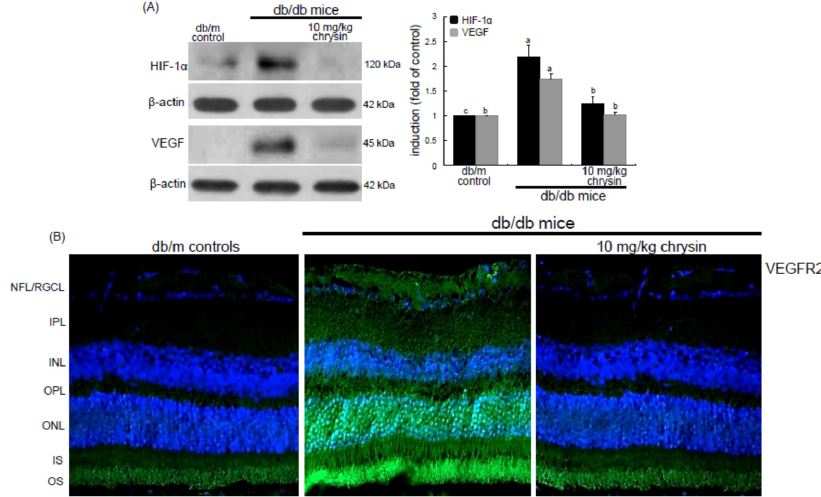
Figure 3. Inhibition of retinal tissue induction of HIF ‐ 1 α , VEGF and VEGFR2 by chrysin. The db/db mice were orally supplemented with 10 mg/kg chrysin daily for 10 weeks. The db/m mice were introduced as control animals. Mouse retinal tissue extracts were subject to Western blot analysis with a primary antibody against HIF ‐ 1 α and VEGF ( A ). β‐ Actin protein was used as an internal control. Bar graphs (mean ± SEM, n = 3) in the right panel represent densitometric results of left blot bands. Values not sharing a common letter differ, p < 0.05. Histological sections of mouse retina were immunohistochemically stained using a primary antibody of VEGFR2 ( B ). The VEGFR2 was identified as FITC-green staining and the sections were counter-stained with 4 (cid:48) ,6-diamidino-2-phenylindole (blue) for the nuclear staining. Magnification: 200 × . Retinal layers are labeled as follows: neurofiber layer/ganglion cell layer (NFL/GCL), inner plexiform layer (IPL), inner nuclear layer (INL), outer plexiform layer (OPL), outer nuclear layer (ONL), and photoreceptor inner segment/outer segment